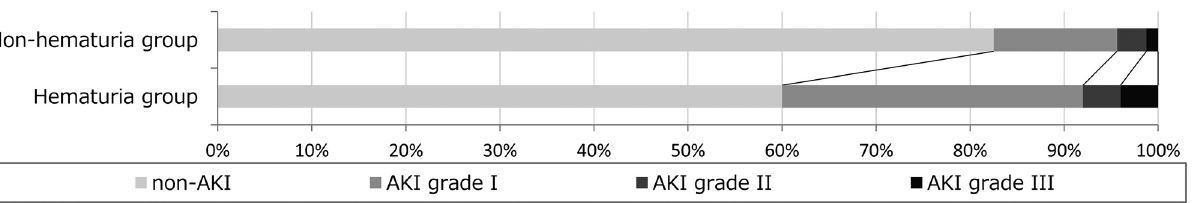
Figure 2: Incidence of AKI among patients with and without intraoperative gross hematuria. AKI, acute kidney